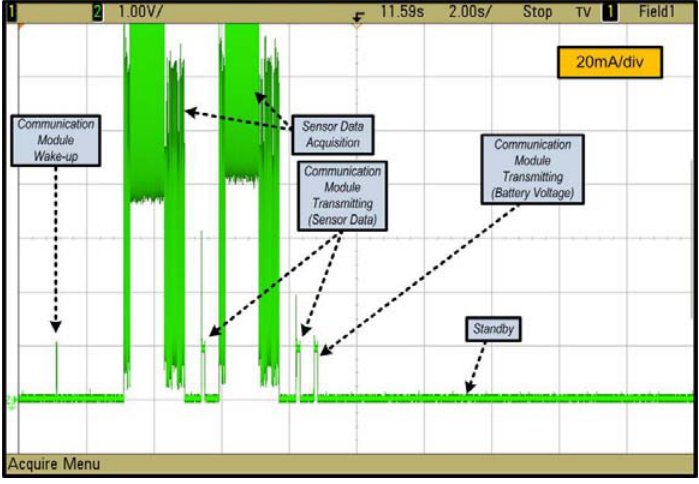
Figure 5. Consumption states of the GAIA Soil-Mote: “standby” = 0.25 mA, “communication module wake-up” = 20 mA, “acquisition” ≈ 110 mA, “communication module transmitting (Sensor Data and Battery Voltage)” = 25